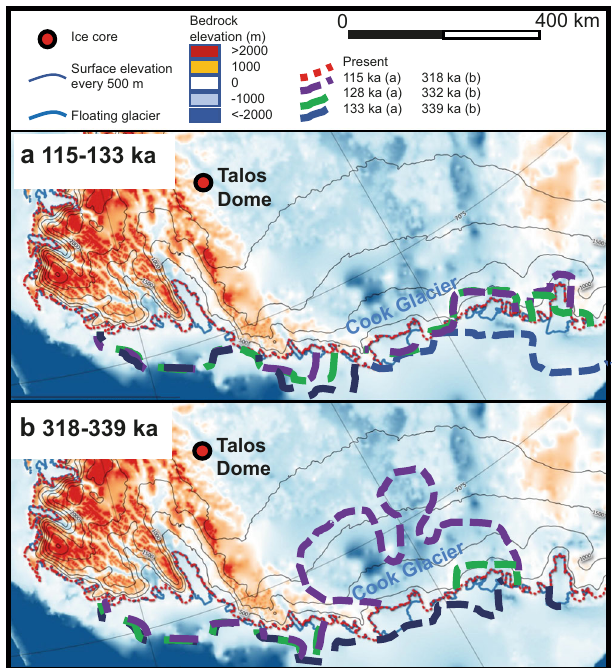
Fig. 4 | Interglacial grounding line retreat of the Wilkes Subglacial Basin ice sheet simulated by the Grenoble Ice Sheet and Land Ice (GRISLI) GS-5 experi- ment at three different time intervals at 40km resolution. a Grounding line displacement during Marine Isotopic Stage (MIS) 5.5 at 133ka (blue dashed line), 128ka (green dashed line) and 115 ka (purple dashed line). b Grounding line dis- placement during MIS 9.3 at 339ka (blue dashed line), 332ka (green dashed line) and 318ka (purple dashed line). The map also shows the subglacial bedrock ele- vation above sea level (colour shading, m), the Antarctic ice sheet present-day surfaceelevationabovesealevel(contours,m),andthepresent-daygroundingline position 6 (red dashed line). Map created using the Quantarctica GIS package 69 developed by the Norwegian Polar Institute and published under the Creative Commons Attribution 4.0 International